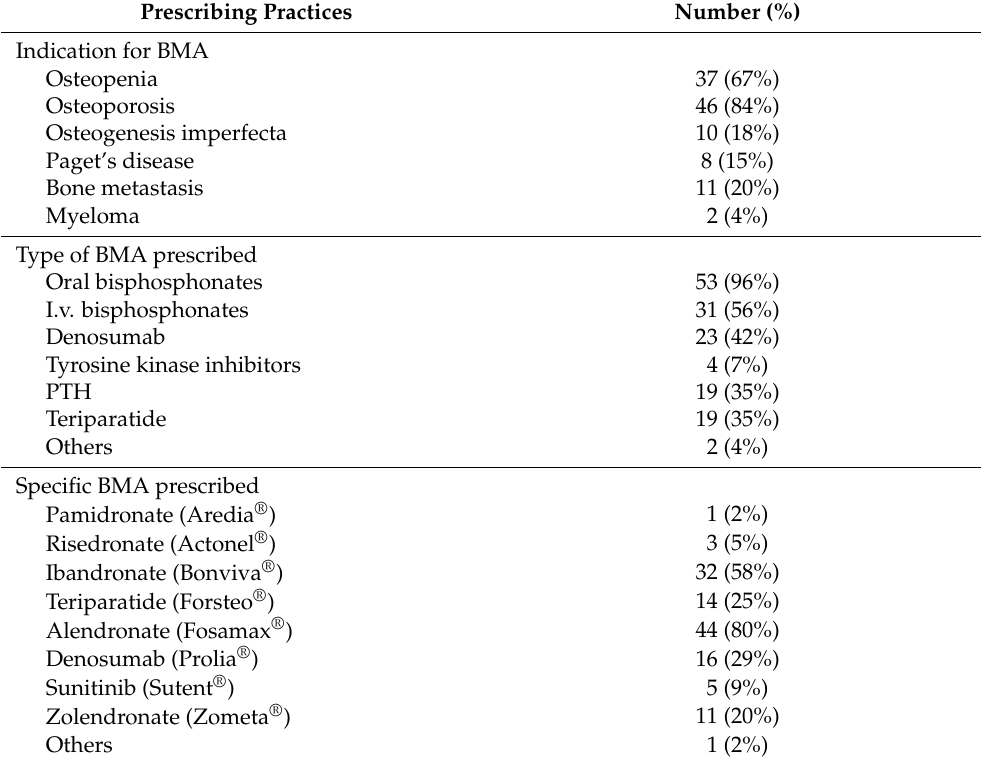
Table 4. Survey respondents’ prescribing practices.